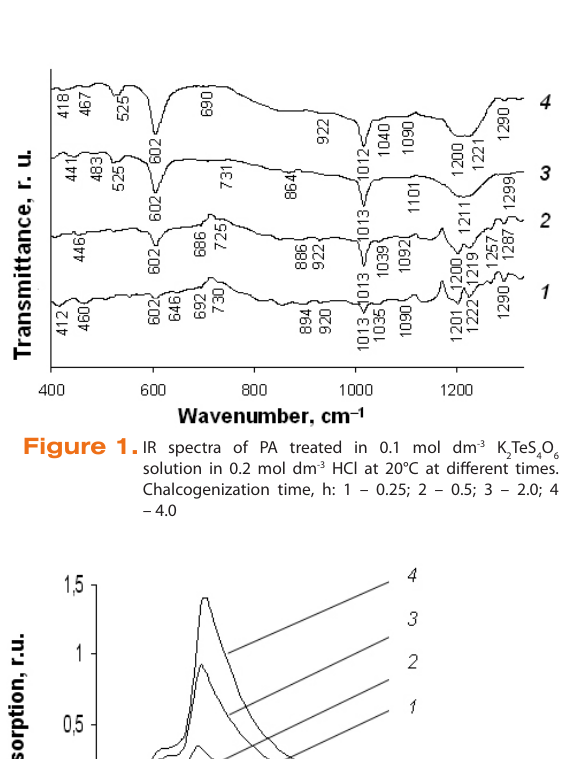
TeS O 2 4 6 solution in 0.2 mol dm -3 HCl at 20°C at different times.